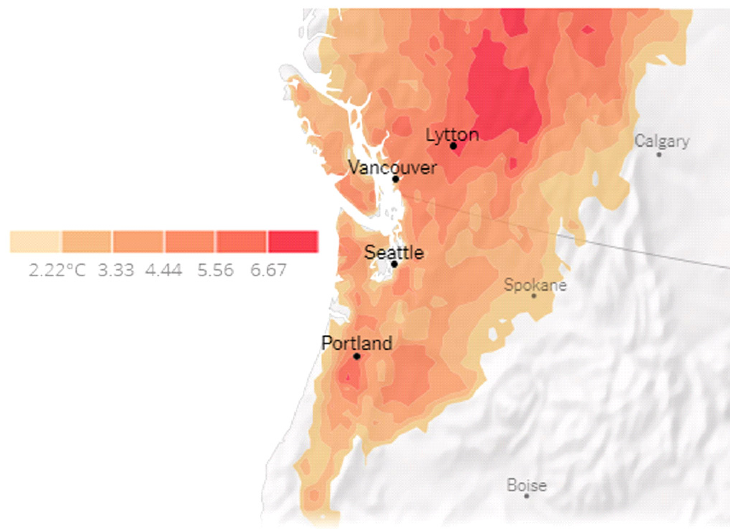
Figure 4. How much warm temperature records were exceeded in June 2021 compared to the highest temperatures from 1950–2020. Source: Geert Jan van Oldenborgh based on ERA5 reanalysis from Copernicus/ECMWF.